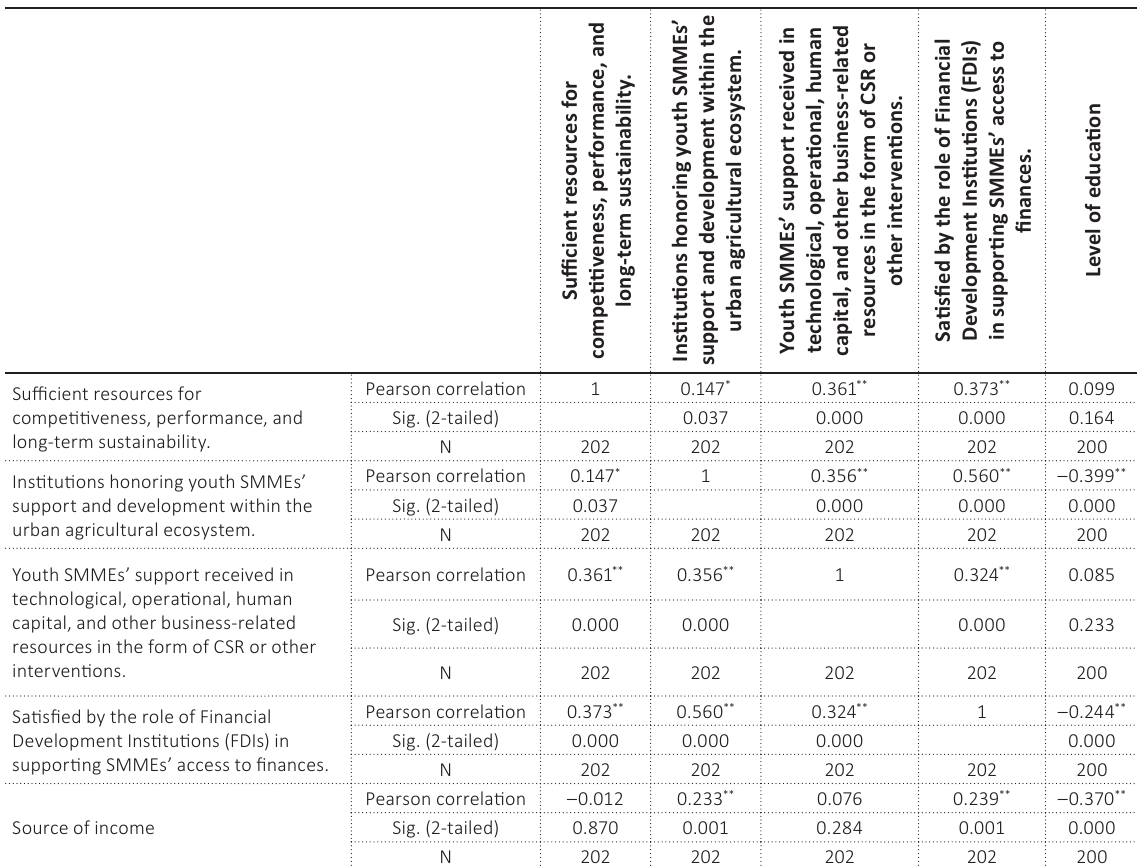
Table 4. Correlation